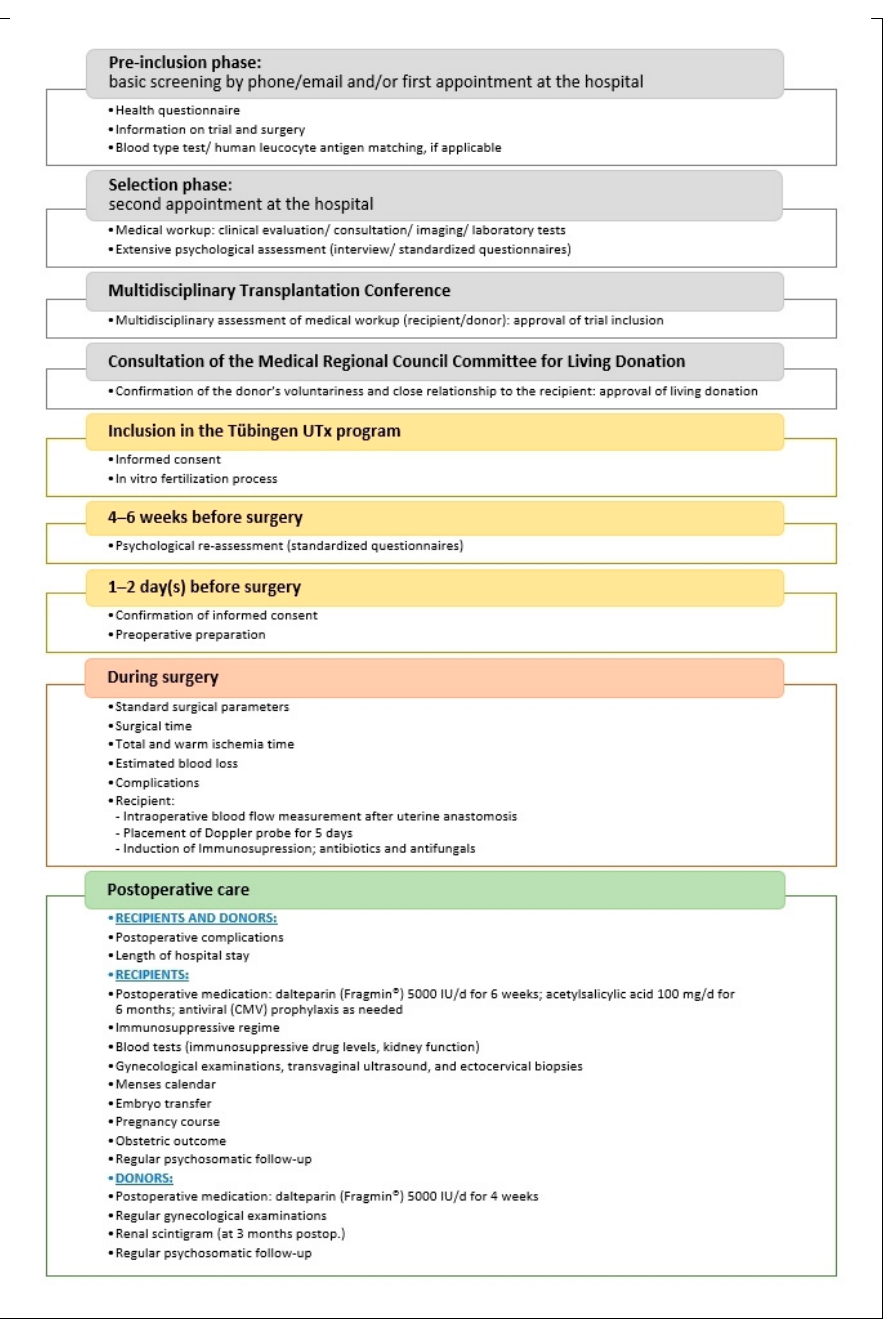
Figure 1. Overview of screening procedures, preoperative investigations, intraoperative checkpoints, and postoperative care in the Tübingen uterus transplantation (UTx) program (modified from